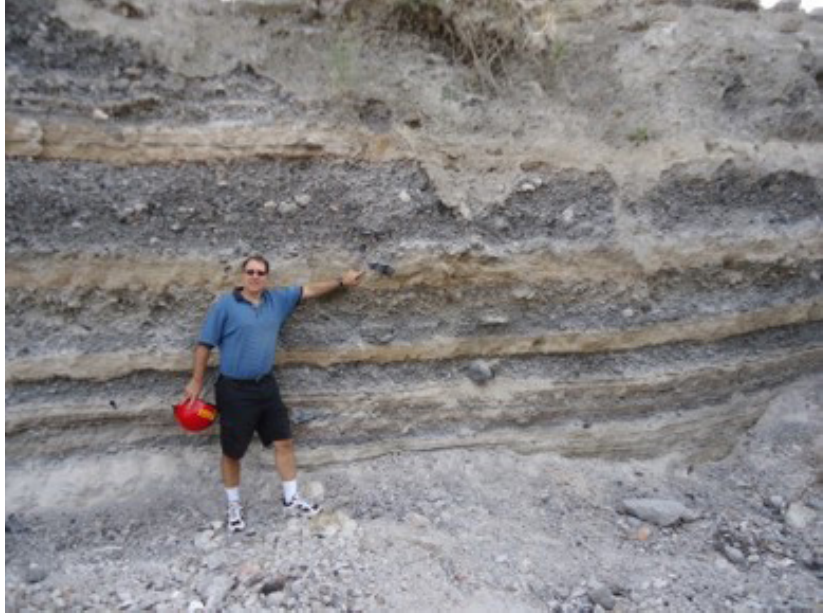
Figure 6. Obsidian deposits exposed by modern construction activities.